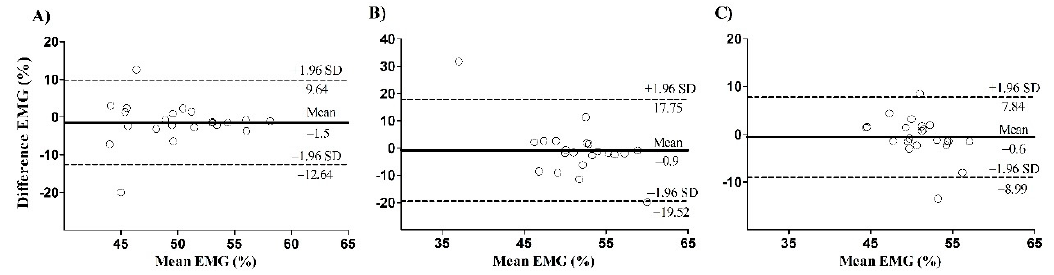
Figure 4. Bland–Altman plot of di ff erence EMG for the lateralis gastrocnemius ( A ), the medialis